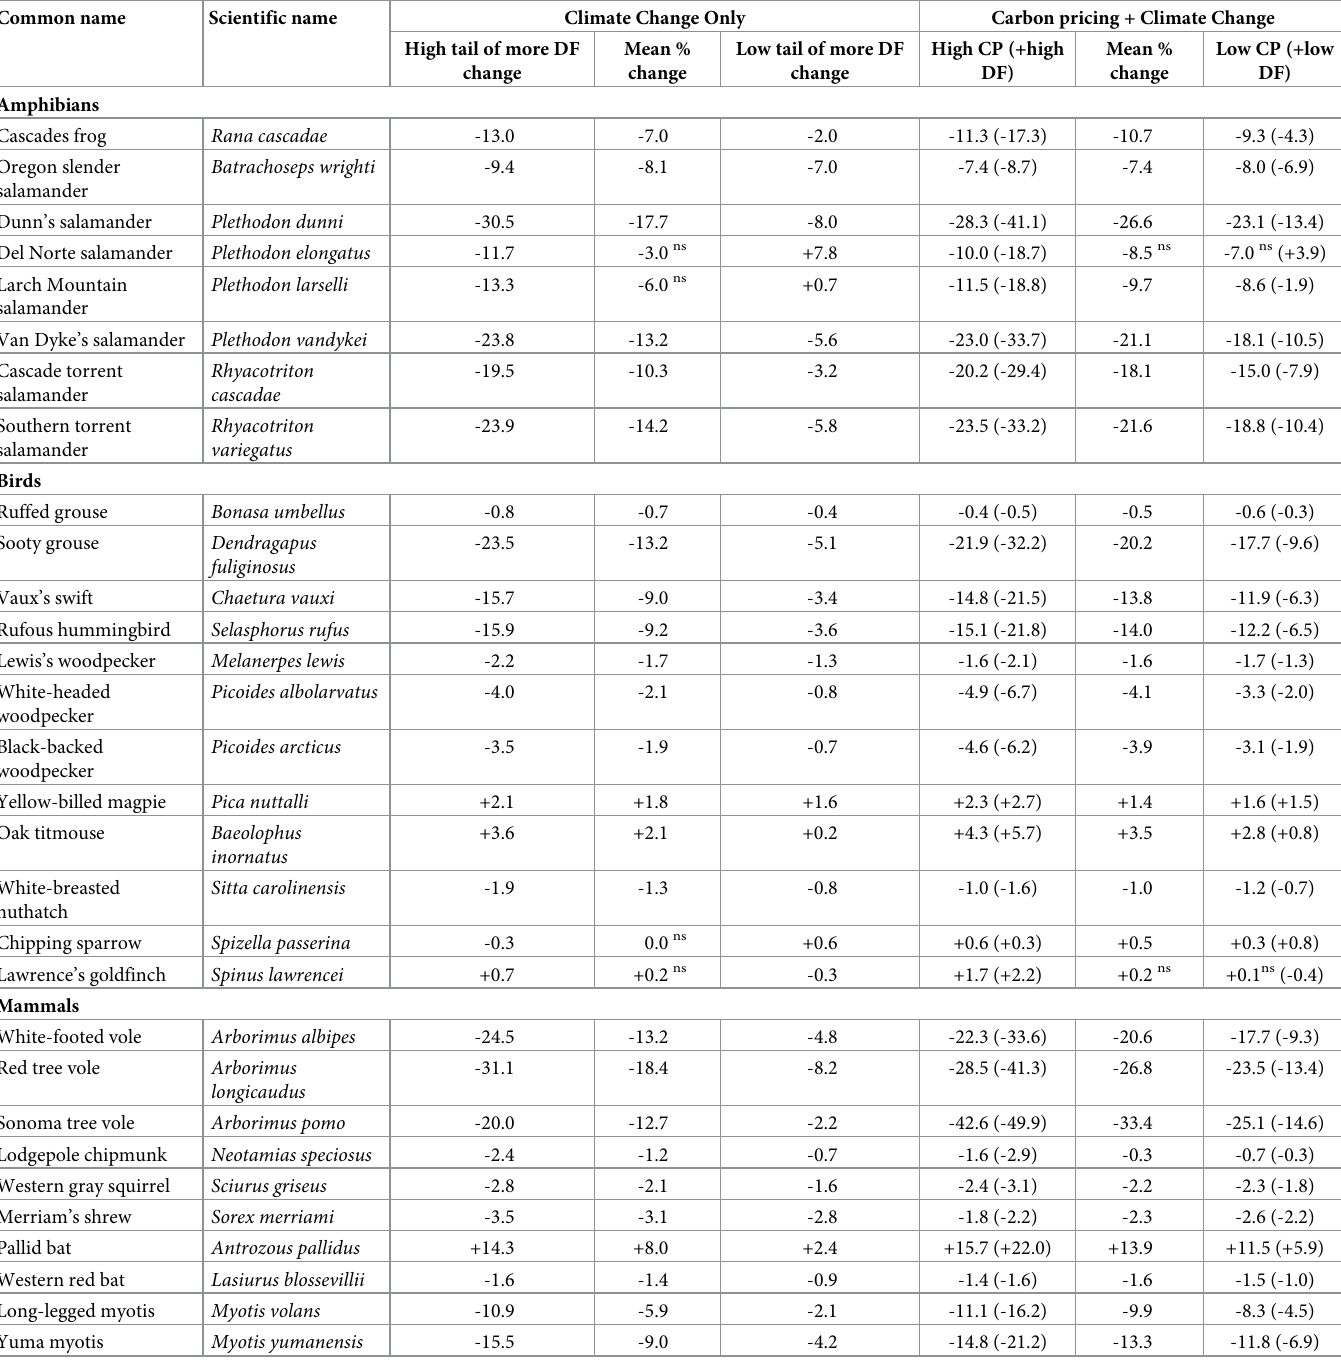
Table 1. Forest-dependent terrestrial vertebrates ( n = 35) in taxonomic order, with percent change in potential habitat presented for our scenarios relative to the baseline. ‘Mean % change’ is the change, through 2100, in the number of FIA plots considered suitable potential habitat (based on associations shown in S1 Table), across all 1000 simulations in each main scenario relative to the baseline, across a species’ range, In the Climate Change Only section, results presented in columns for ‘High tail’ and ‘Low tail’ of DF (Douglas-fir) change represent our prediction interval around the mean (see Methods). In the Carbon Pricing + Climate Change section, ‘High CP’ represents the mean % change from the high carbon price version of that scenario, with ‘(+high DF)’ the additional prediction interval from the high tail of DF change. ‘Low CP’ represents the mean % change from the low carbon price version of that scenario, with ‘(+low DF)’ the additional prediction interval from the low tail of DF change (see Methods for additional